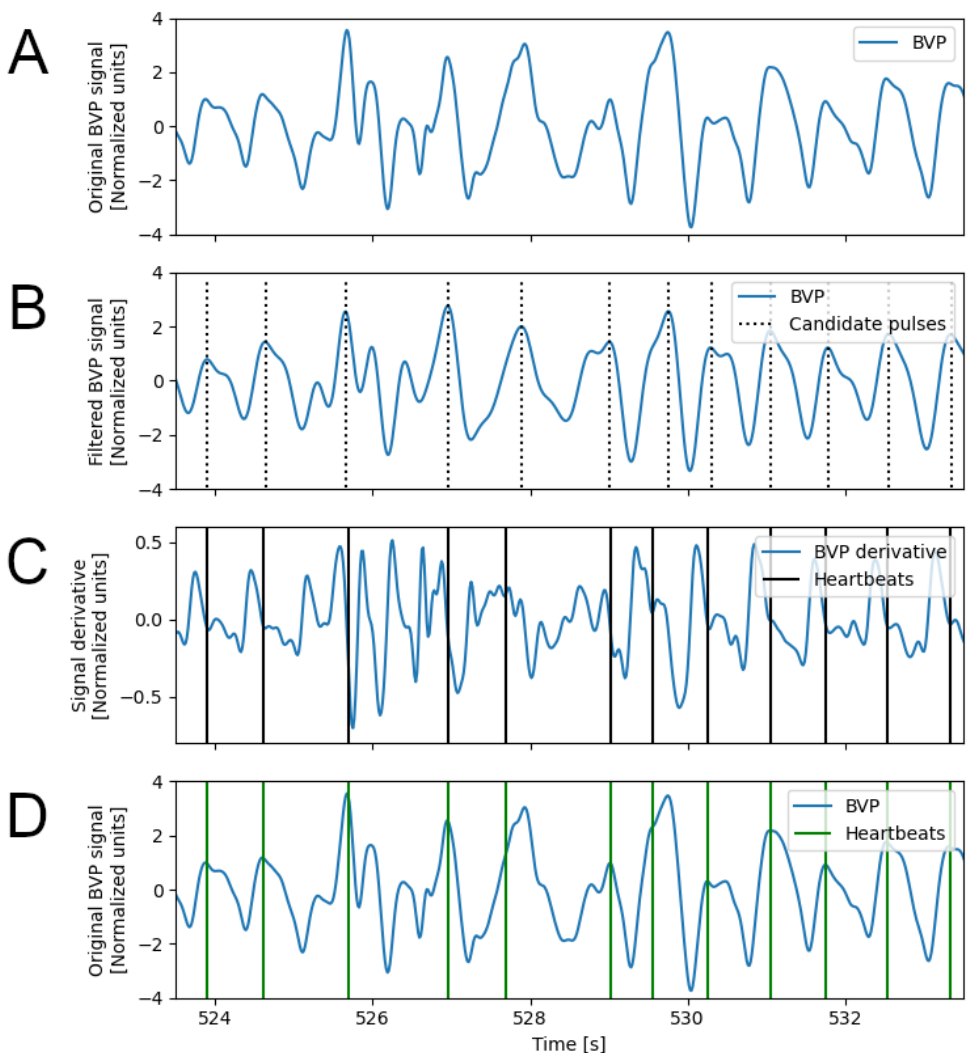
Figure 2. Steps of the DBD algorithm; portion of BVP signal affected by motion artifacts. ( A ) Original BVP signal on which the DBD algorithm is applied; ( B ) Identification of the candidate pulses on the filtered BVP signal; ( C ) Identification of the zeros (or minima) on the derivative of the BVP signal; ( D ) Original BVP signal with the detected heartbeats. Note the effect of the motion artifacts on the heartbeat detection